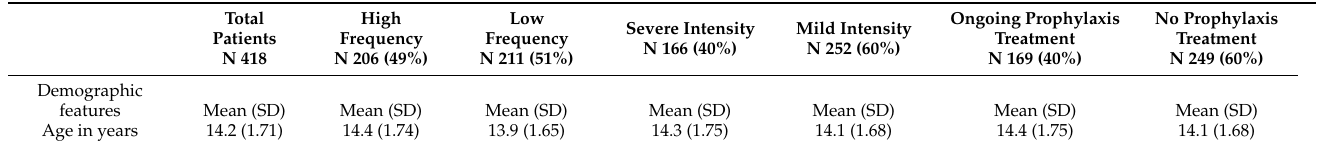
Table 1. Distribution of patients according to frequency, intensity of attacks, and use of prophylaxis in the general sample and in the different periods. SD: standard